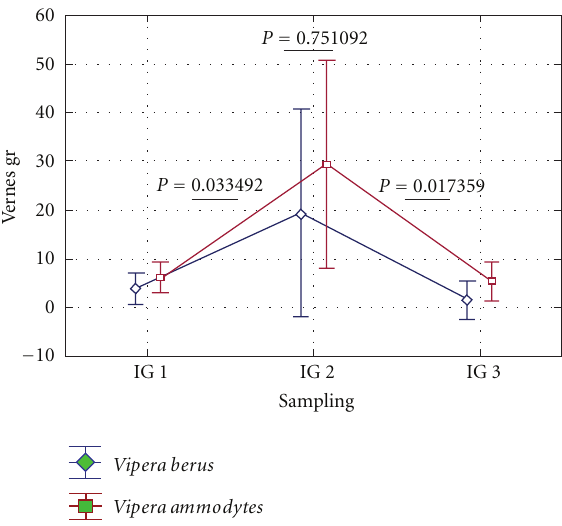
Figure 4: Changes in total gamma globulin concentration during an annual cycle in V. ammodytes and V.